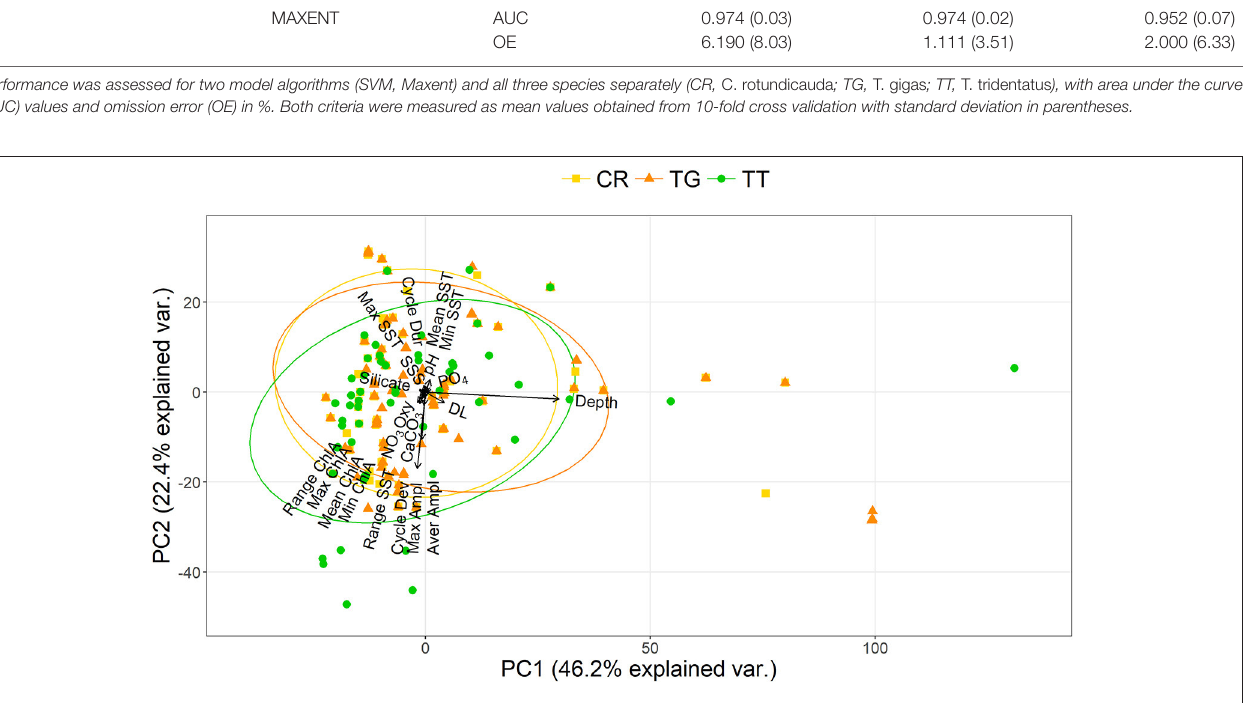
FIGURE 1 | Niche overlap analysis of the three Asian horseshoe crab species showing the principal component analysis plots of the environmental “hypervolume” for 23 predictor variables [CR, C. rotundicauda ( ); TG, T. gigas ( ); TT, T. tridentatus ( )]. Ellipses represent 68% of the hypervolume for each species; points represent presence of each species at environmentally unique locations. The positions of variable names have been adjusted to prevent